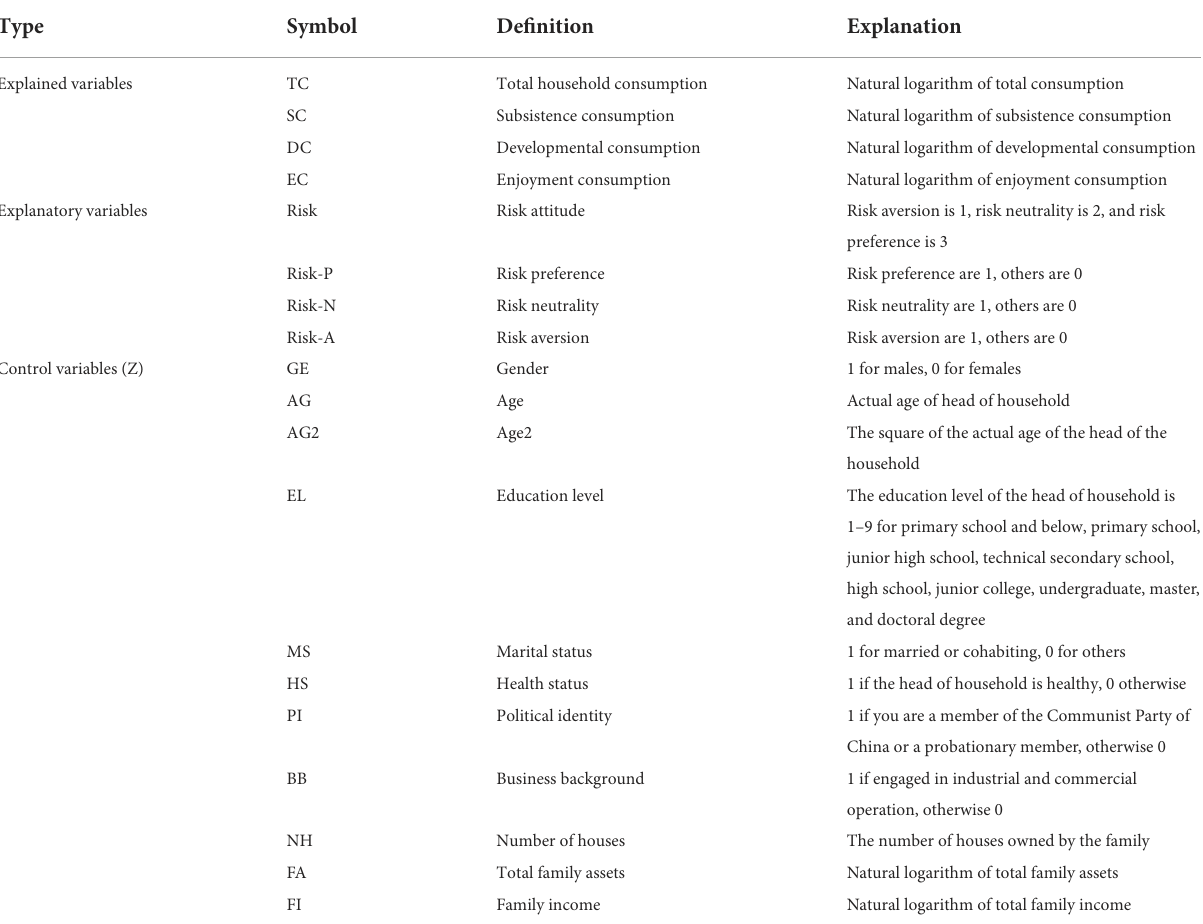
TABLE 1 The specific definitions of